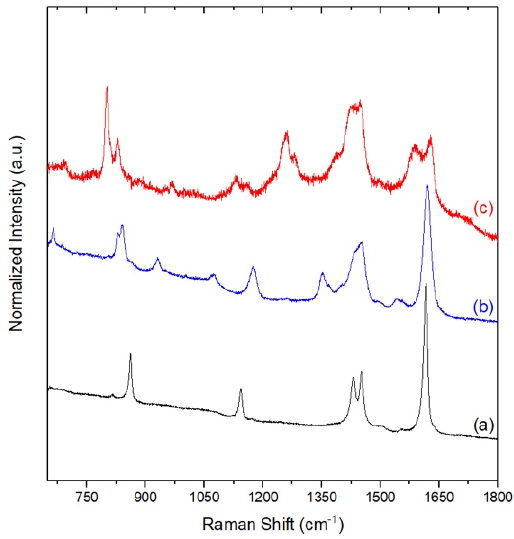
Figure 4. Raman spectra of ( a ) UiO-66-H, ( b ) UiO-66-NO 2 and ( c ) UiO-66-NH 2 films.